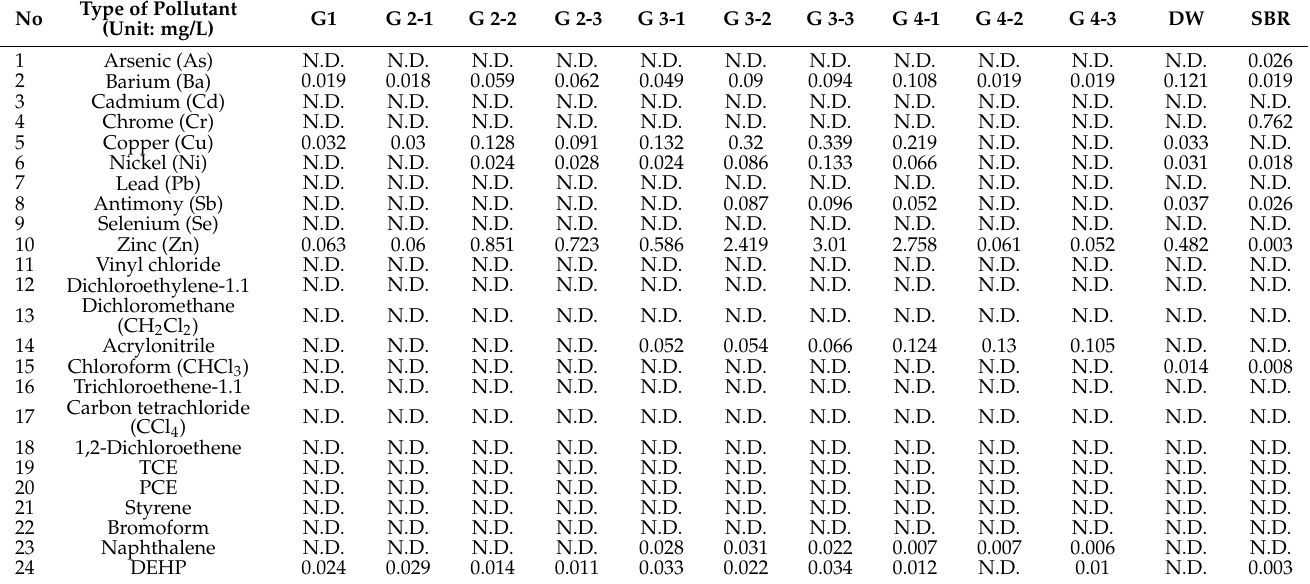
Table 2. Results of laundry water analysis on fire protection suits by group distribution.